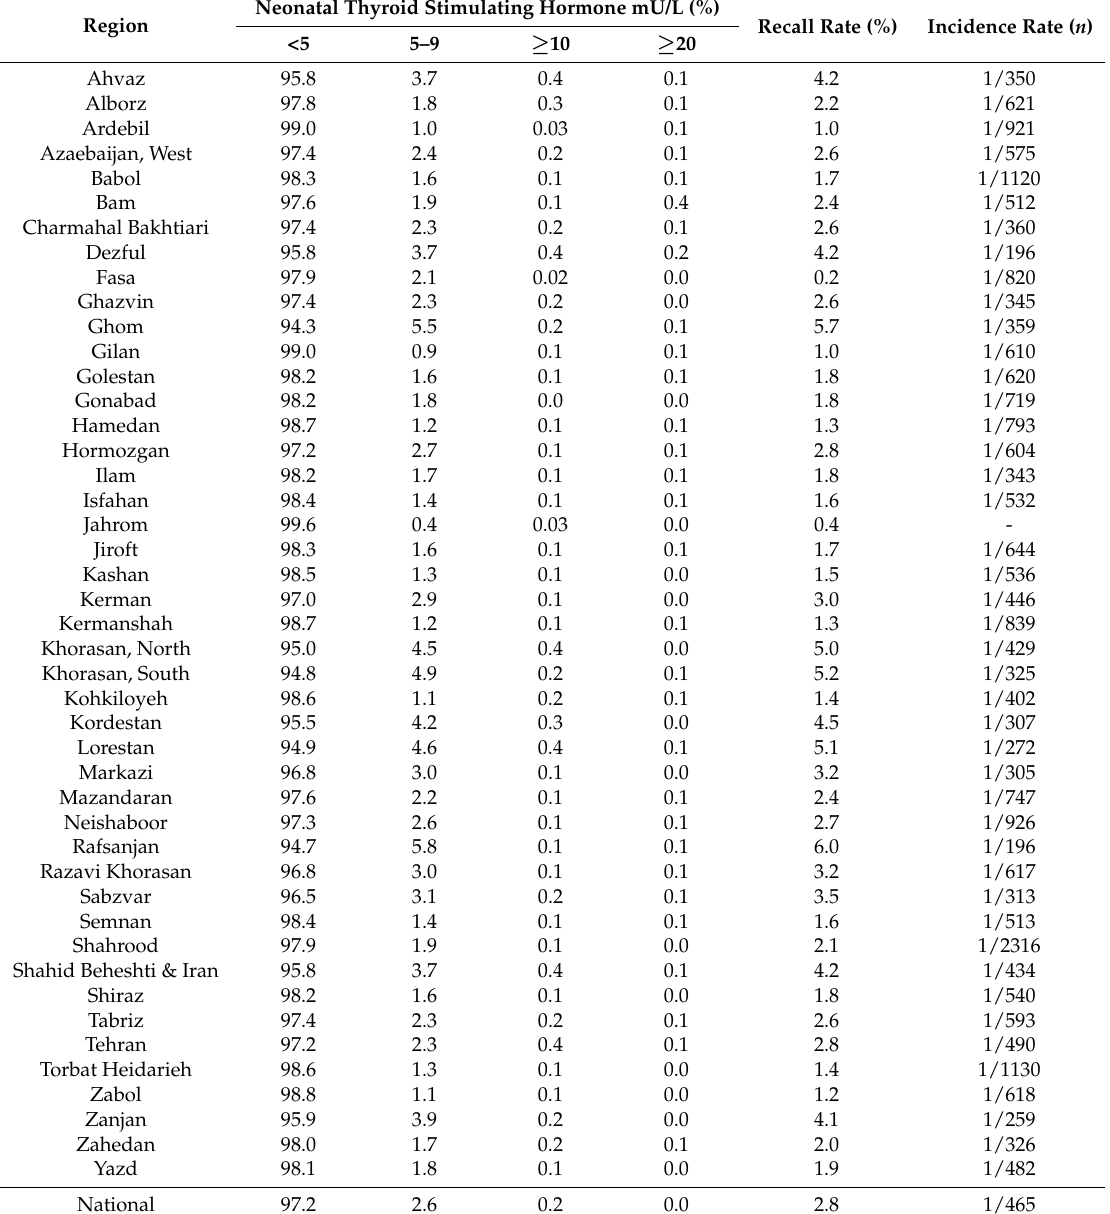
Table 1. Frequency of neonatal thyroid stimulating hormone, recall rate, and incidence of congenital hypothyroidism